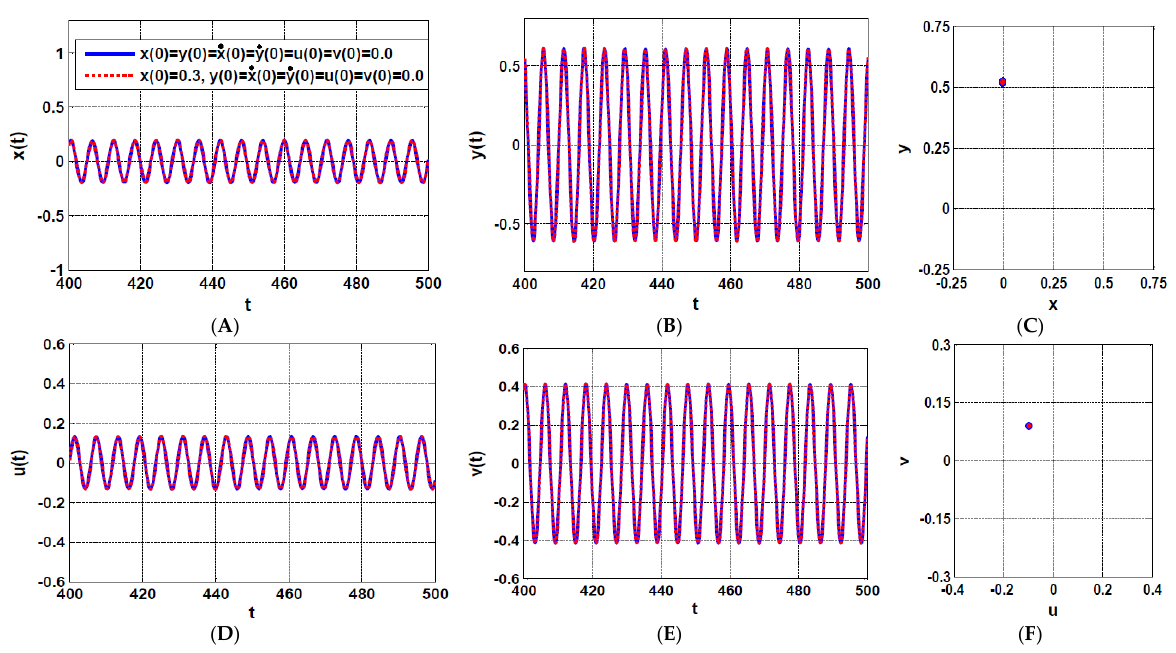
Figure 12. The rotor system steady-state time-response according to the point p 2 shown in Figure 10B (i.e., when 𝑓 = 0.075 , 𝜂 1 𝜂 3 = 0.15 𝜂 2 = 0.0, and 𝜂 4 = 1 ): ( A – C ) temporal oscillation in 𝑋 and 𝑌 directions and the corresponding Poincaré map, respectively, ( D – F ) temporal oscillations of the U-IRC and V-IRC and the corresponding Poincaré map, respectively.